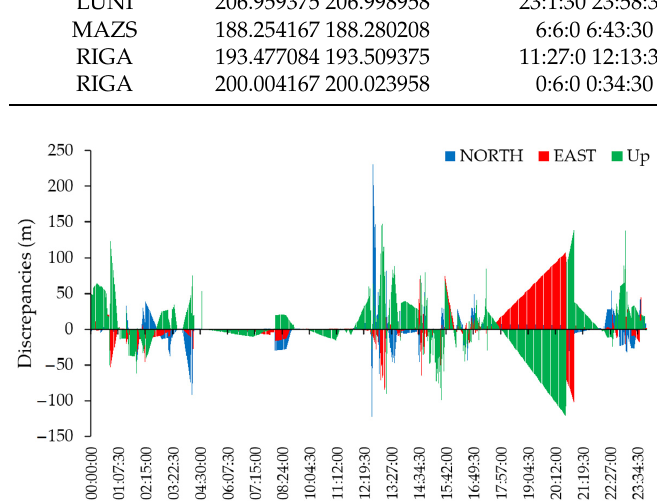
The detailed analysis of the discrepancies for the two stations LUNI and SALP is shown in Figures 10 and 11.